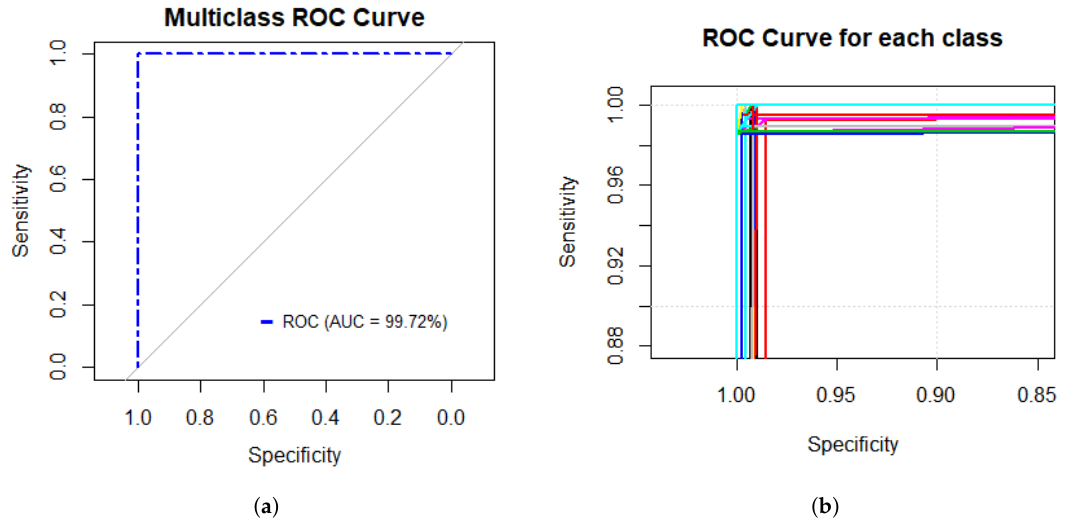
Figure 5. Multiclass receiving operating characteristic (ROC) Curves. ( a ) Multiclass ROC Curve. ( b ) ROC Curve for each